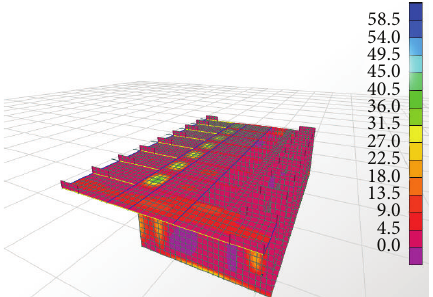
Figure 23: Bending moment distribution of train A/B.